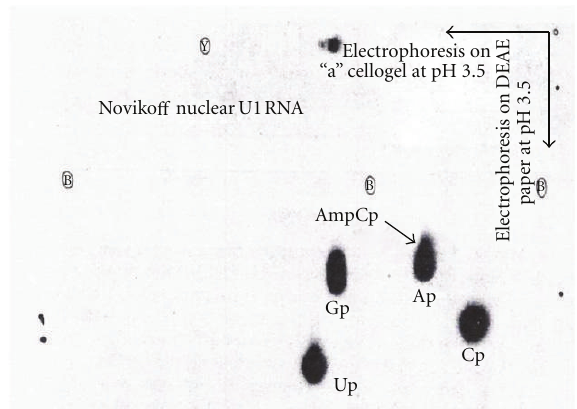
Figure 20: 2D map of U1 RNA digested with T 2 RNase and U 2 RNase [16]. The U1 RNA uniformly labeled with [ 32 P] was digested with T 2 RNase and U 2 RNase. The resistant 5 (cid:2) fragment (spot “a”) was separated from the rest of the hydrolysate by two-dimensional electrophoresis. The first dimension was on cellogel at pH 3.5, and the second dimension was on DEAE paper in 5% acetic acid-NH 4 acetate at pH